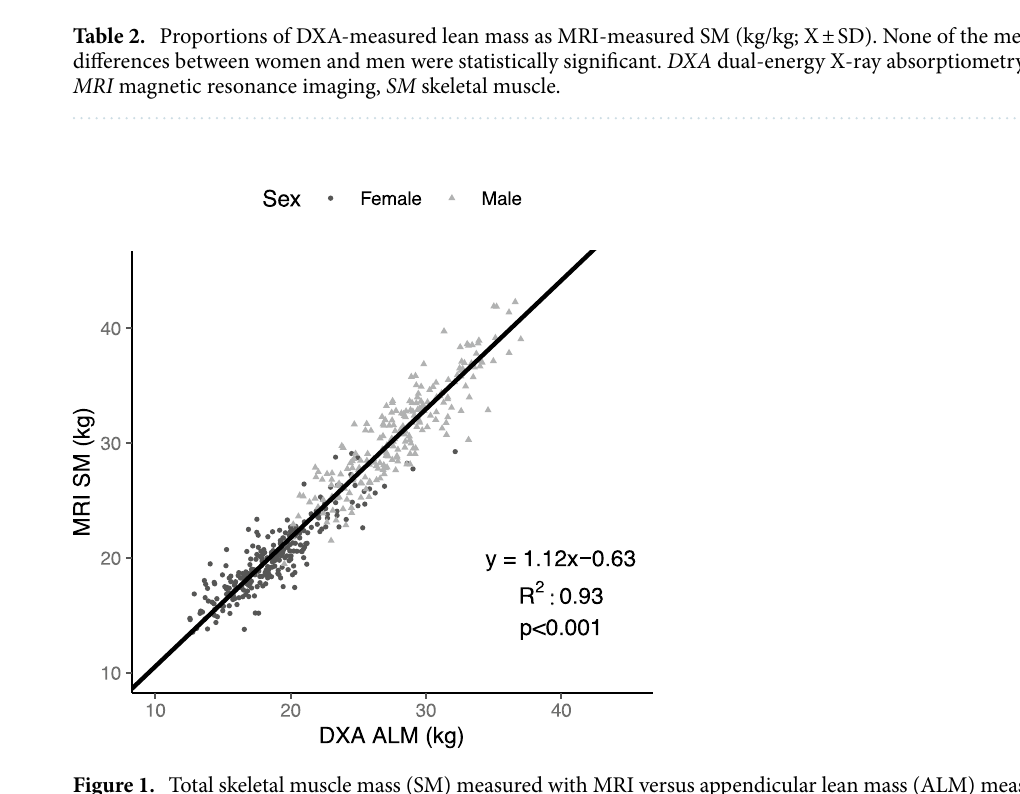
Figure 1. Total skeletal muscle mass (SM) measured with MRI versus appendicular lean mass (ALM) measured with DXA in the whole sample (n = 475). The Deming regression equation, line (solid), and R 2 are shown in the figure (p <